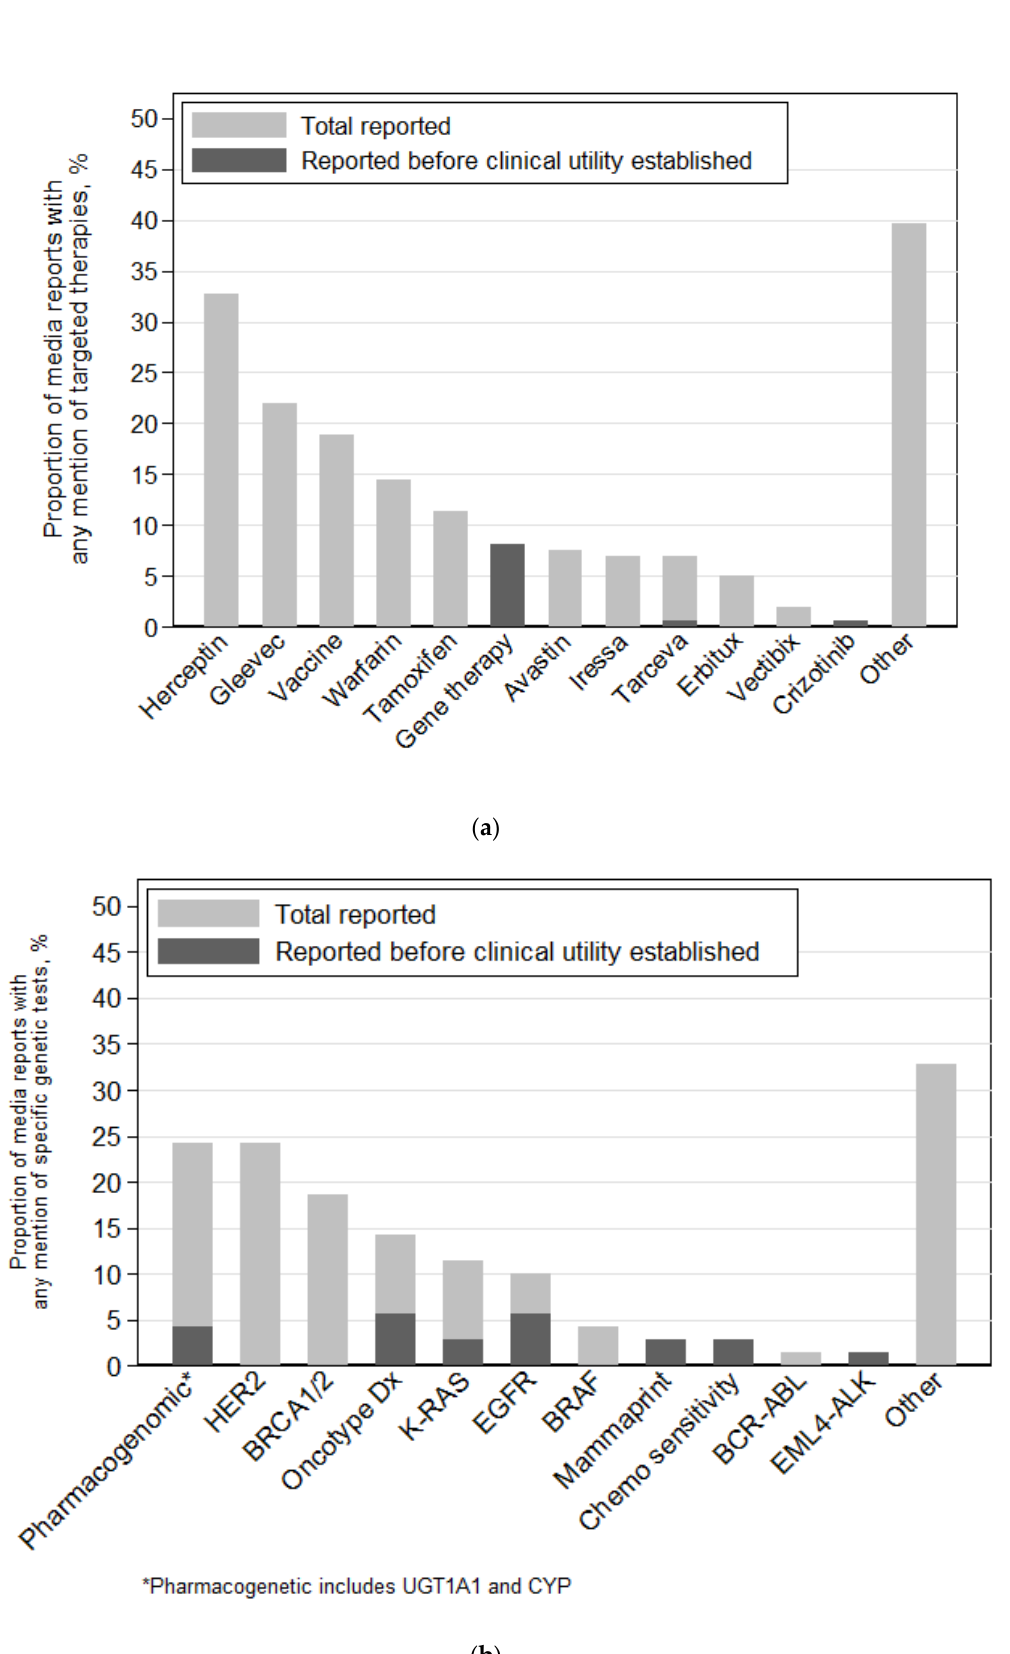
Figure 2. Genetic tests and targeted therapies reported in the media: ( a ) specific genetic tests reported ( n = 70); ( b ) targeted therapies reported ( n = 159).